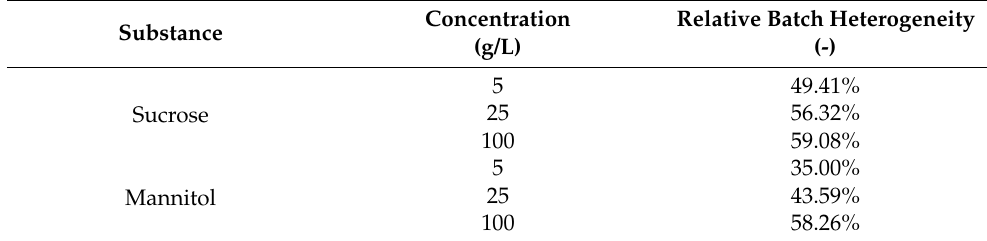
Table 4. Relative batch heterogeneity for different experiments.